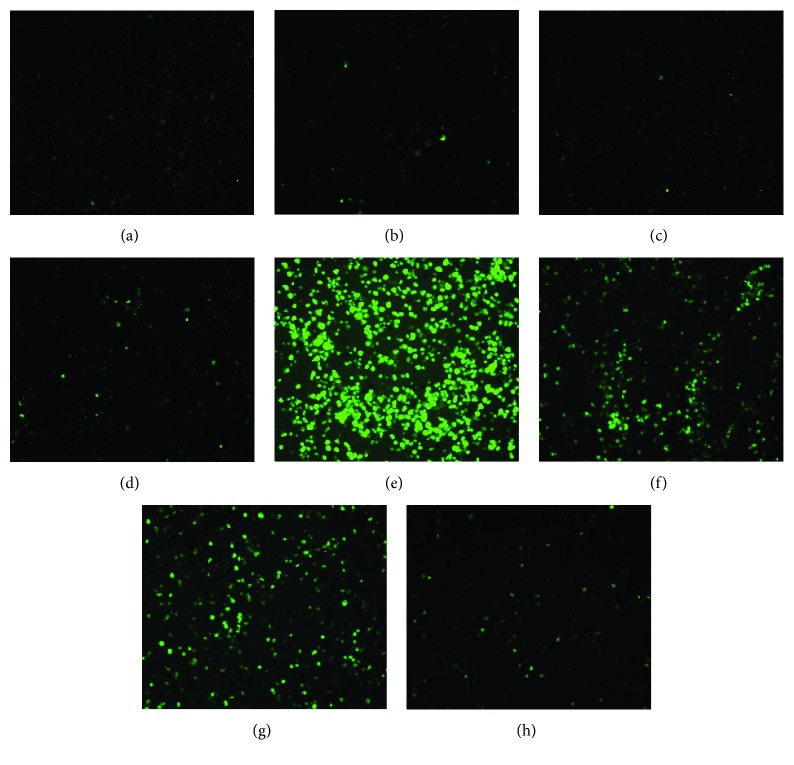
ROS fluorescence intensity in L-02 cells. (a) The control group showed weak ROS fluorescence intensity. (b–d) The GSPE (10, 25, and 50 mg/L for 24 h) groups showed weaker fluorescence intensity than the control group. (e) Intense green fluorescence of ROS was found in the arsenic (25 μM) treatment group. (f–h) The arsenic (25 μM) + GSPE (10, 25, and 50 mg/L) group (for 24 h) displayed gradual decrease in fluorescence intensity with increase in GSPE concentrations. ROS fluorescence intensity was significantly higher in the arsenic group (Figure 3(e)) than in the control group (Figure 3(a)). However, GSPE effectively removed ROS induced by arsenic (Figures 3(f)–3(h)).